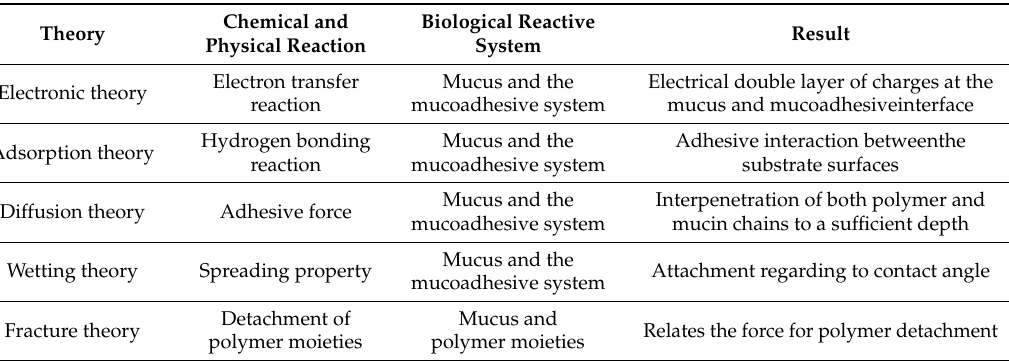
Table 2. Theories of